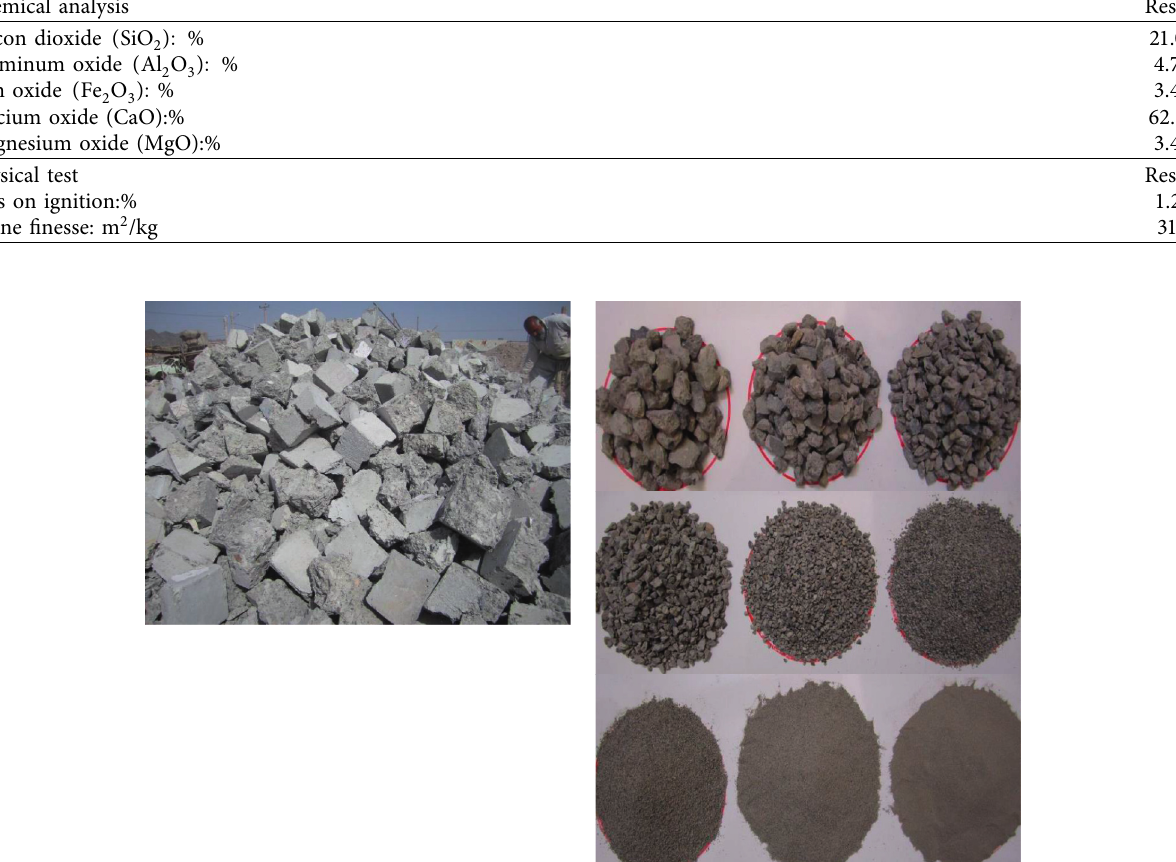
Table 2: Portland cement type II chemical and physical properties.